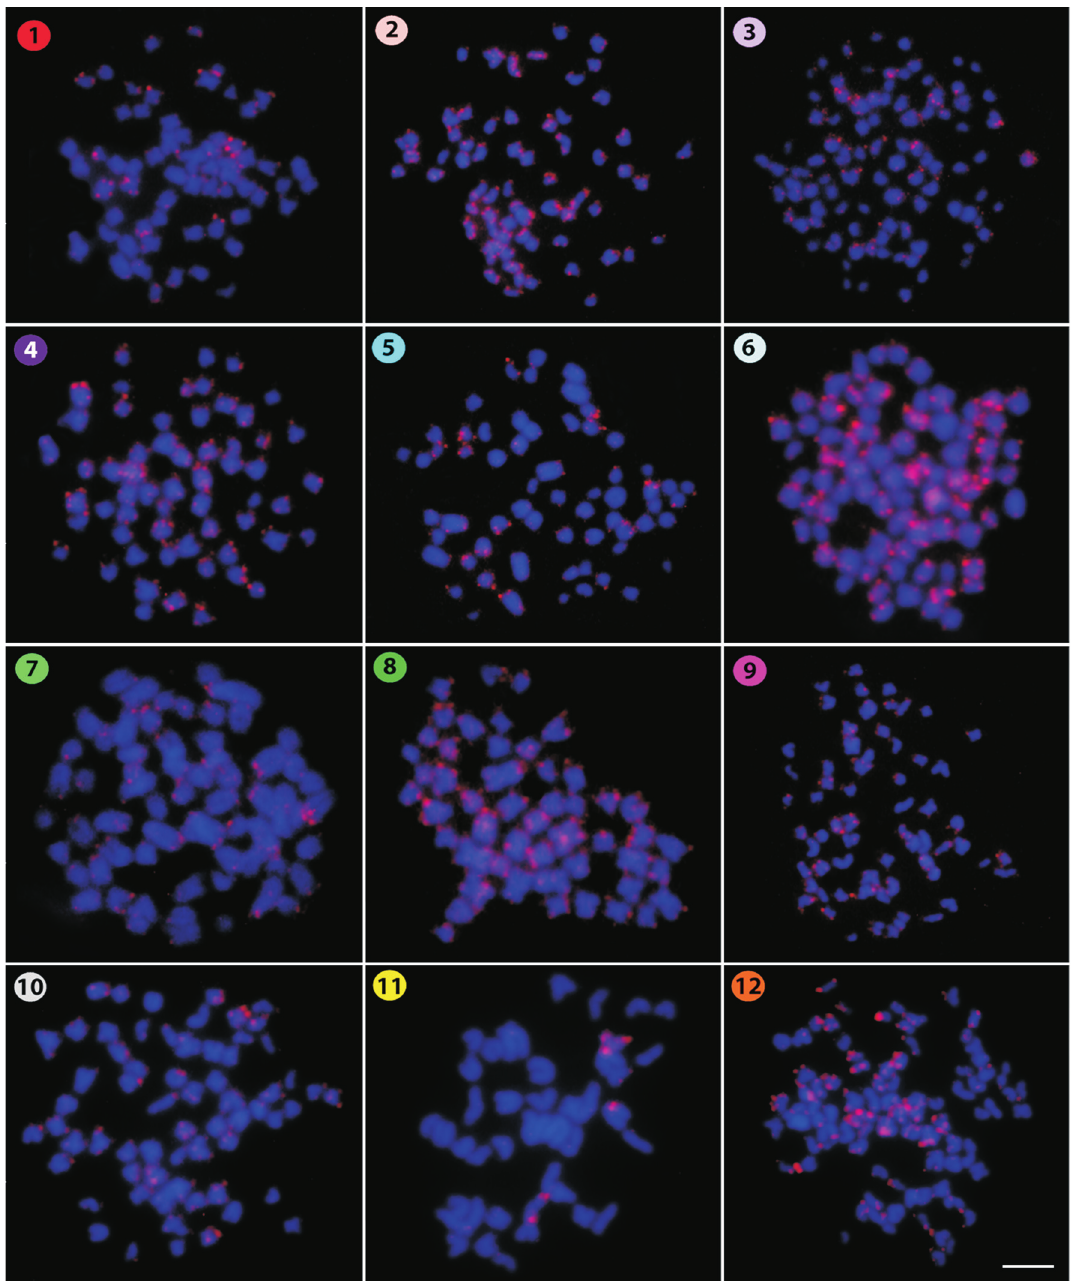
Figure3 -Hybridizationpatternofthe(CAC) 10 microsatelliteprobe(inred)onmetaphaseplatesof Belodontichthystruncates ( 1 ); Kryptopterusbicirrhis ( 2 ); Kryptopterusgeminus ( 3 ); Kryptopteruslimpok ( 4 ); Kryptopterusmacrocephalus ( 5 ); Micronemachevevi ( 6 ); Ompokfumidus ( 7 ); Ompoksiluroides ( 8 ); Phalacronotus apogon ( 9 ); Phalacronotus bleekeri ( 10 ); Silurichthys phaiosoma ( 11 ) and Wallago attu ( 12 ). Scale bar = 5 (cid:2)